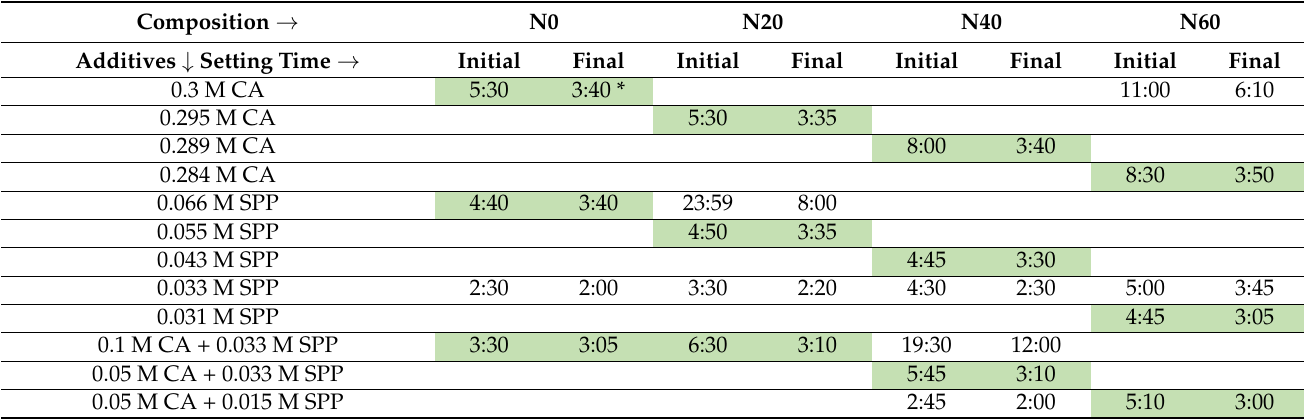
Table 4. Setting time of cements based on Mg x Ca 3 − x (PO 4 ) 2 powders for obtaining ceramics composi- tions N0, N20, N40, and